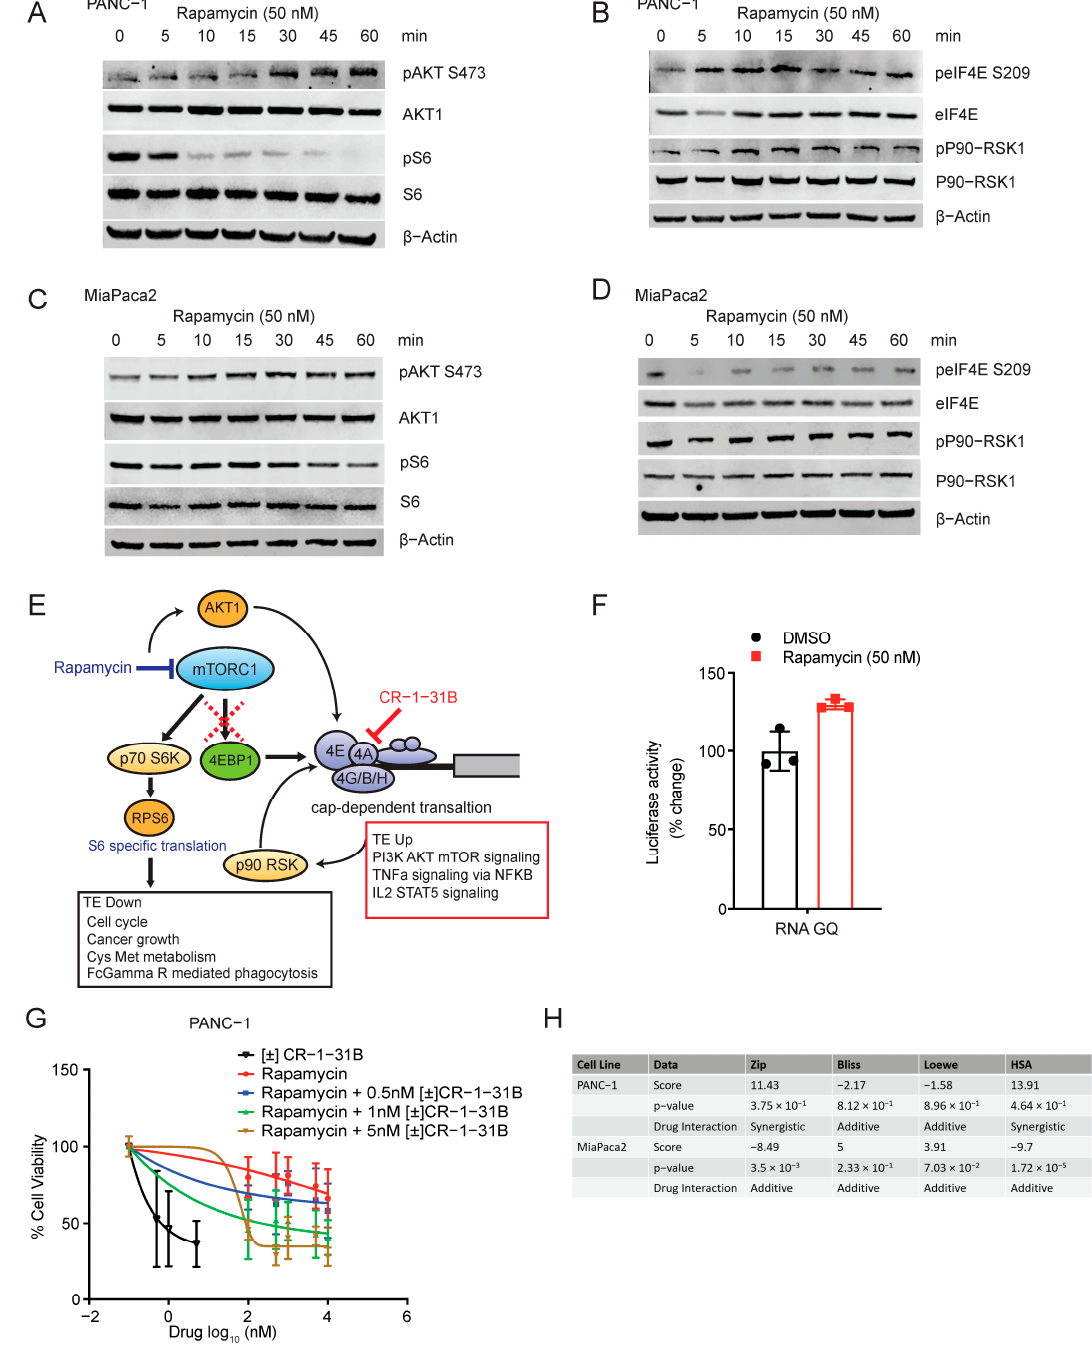
Figure 4. Rapamycin activates translation through feedback activation of AKT1 and eIF4E. ( A ) Im- munoblot showing upregulation in the phospho-AKT1 and downregulation in phospho-S6 following rapamycin treatment (50 nM) for the indicated time points in PANC-1 cells. Total AKT1 and total